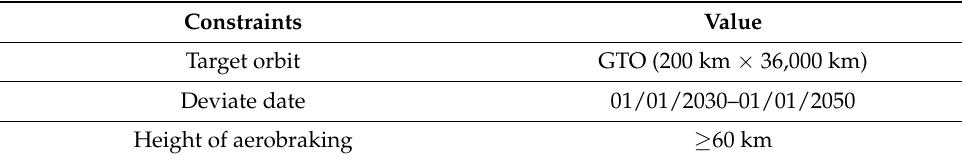
Table 2. Constraints of the Earth aerobraking capture